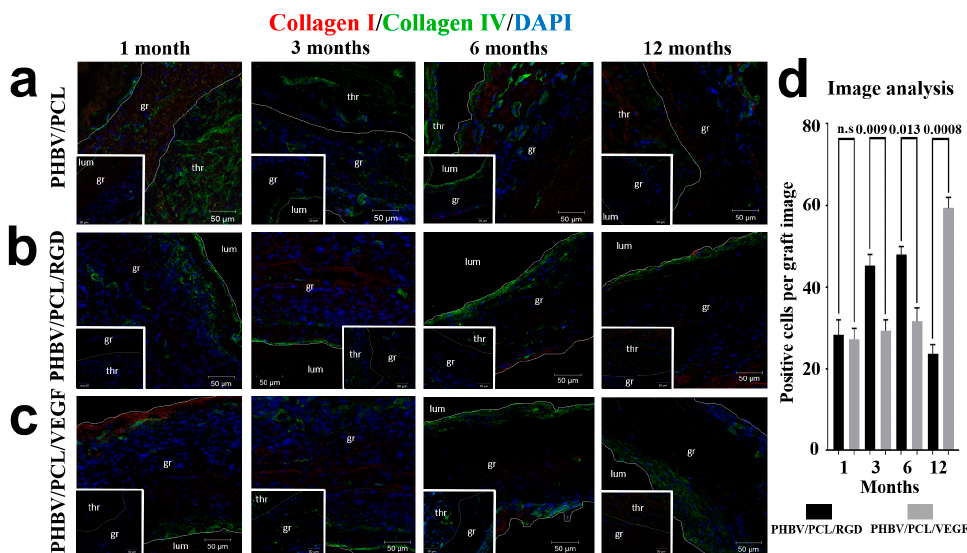
Figure 5. Combined collagen I (red), collagen IV (green), and DAPI (blue) staining. Representative images of: ( a ) PHBV/PCL grafts; ( b ) PHBV/PCL/RGD grafts; ( c ) PHBV/PCL/VEGF grafts. Thr is for thrombus, gr is for graft, lum is for lumen. Images of corresponding patent PHBV/PCL along with occluded PHBV/PCL/RGD and PHBV/PCL/VEGF grafts are presented as bottom inserts; ( d ) Quantitative